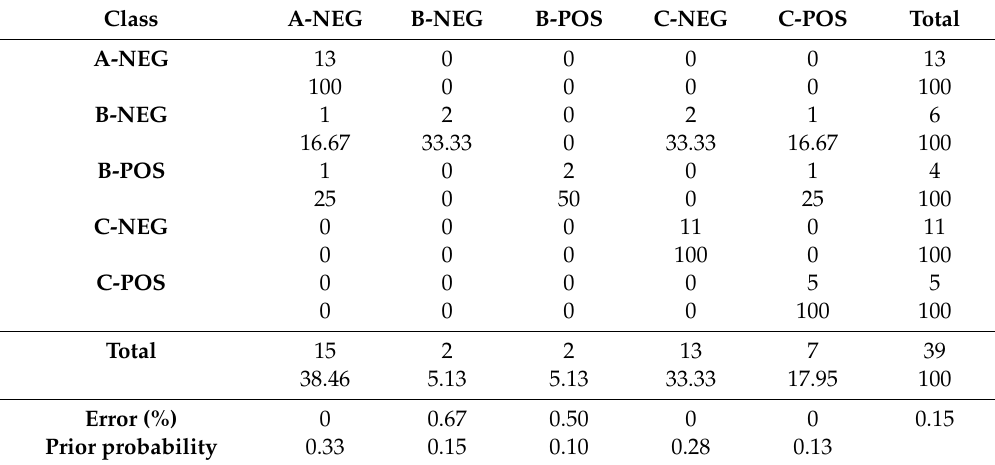
Table 3. Linear discrimination analysis (LDA): the assignment of individuals (milk samples) to each class (no samples were found in Class A-POS).